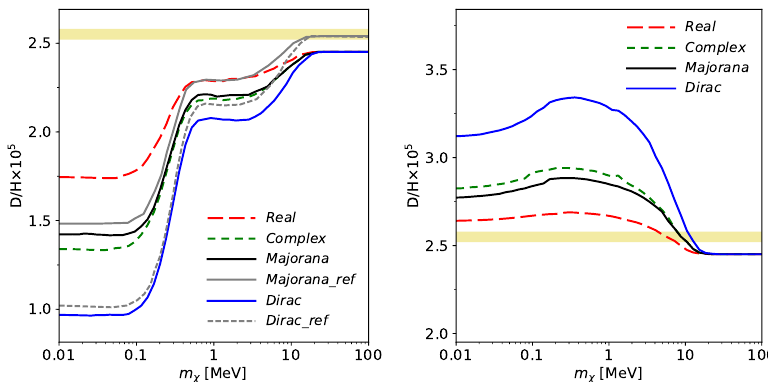
Figure 5. The deuterium abundance as a function of Weakly Interacting Massive Particles (WIMP) mass if the WIMP is a real scalar (dashed red), a complex scalars (dotted green), Majorana fermion (solid black), Dirac fermion (solid blue). The left plot is for electromagnetically coupled WIMPs (coupling to electrons or photons) and the right plot is for neutrino coupling. The grey lines are for comparison to [38,39]. The deviations are due to different choices of nuclear rates. The yellow horisontal bands are the observed ratio of D/H [8]. Figure from